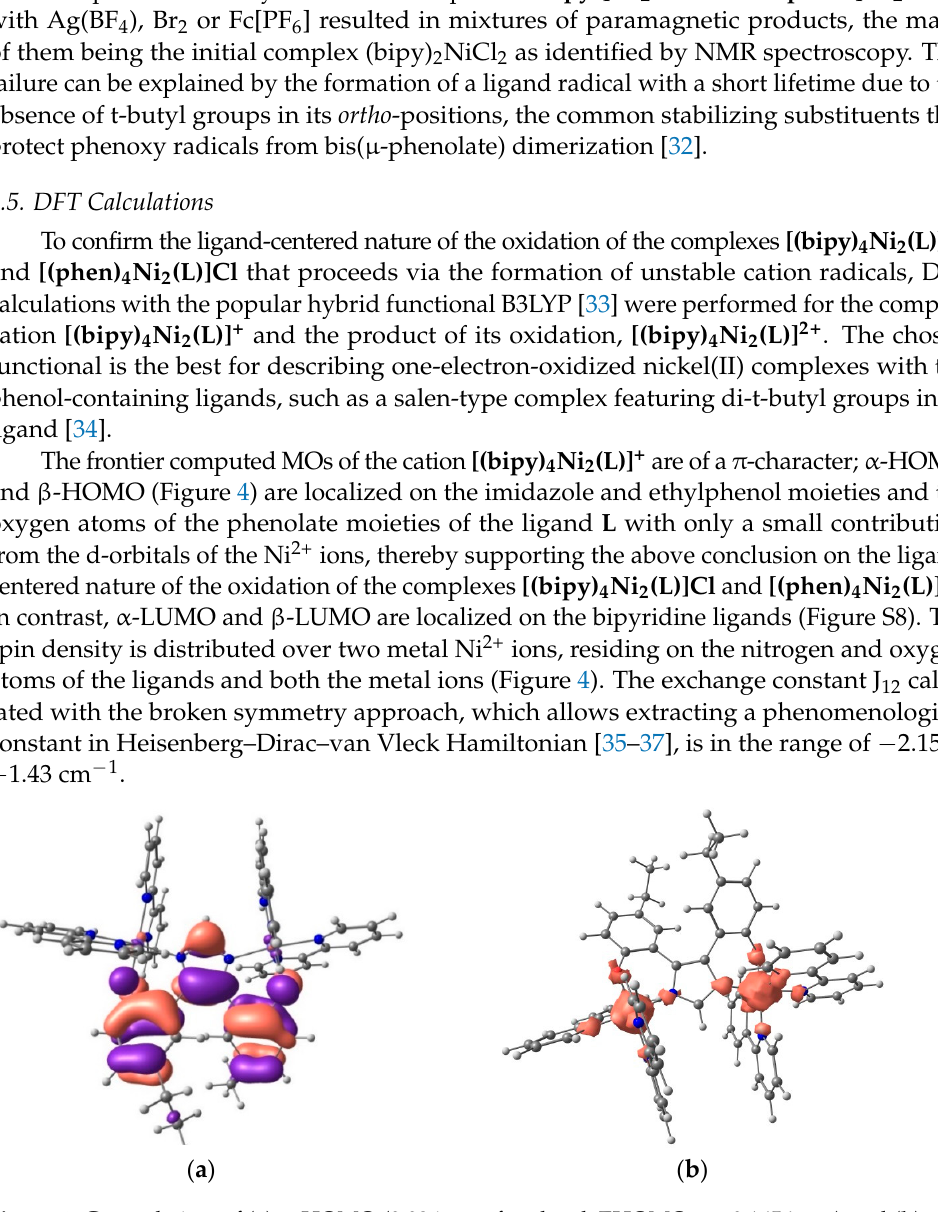
Figure 4. General view of ( a ) α‐ HOMO (0.03 isosurface level; EHOMO = − 0.1656 a.u.) and ( b ) spin density (0.0065 isosurface level) in the cation [(bipy) 4 Ni 2 (L)] + . The calculated energy level diagrams for [(bipy) 4 Ni 2 (L)] + and [(bipy) 4 Ni 2 (L)] 2+ (Fig ‐ ure 5) show that β‐ MOs in the nonoxidized species lie lower than α‐ MOs. The same pat ‐ tern is observed for the oxidized species. In this case, however, the energy difference be ‐ tween α‐ and β‐ MOs is larger, e.g., | Δ E| for α‐ 273 and β‐ 268 is 0.0096 a.u. The MOs of [(bipy) 4 Ni 2 (L)] 2+ are lower in energy than those in [(bipy) 4 Ni 2 (L)] + , with | Δ E HOMO | equal to 0.032 a.u. Figure 5. Calculated energy level diagram for α‐ and β‐ MOs in the cation [(bipy) 4 Ni 2 (L)] + and its oxidized form [(bipy) 4 Ni 2 (L)] 2+ . For the oxidized species [(bipy) 4 Ni 2 (L)] 2+ , the frontier α‐ orbitals are very similar to those in the complex cation [(bipy) 4 Ni 2 (L)] + (Figures 4, 6, S8 and S9); however, the spin density distribution is quite different (Figure 5). In [(bipy) 4 Ni 2 (L)] 2+ , it has an out ‐ of ‐ plane π‐ character and is located on the carbon atoms of the phenyl rings, the oxygen atoms of the phenolate moieties of the ligand L and the nitrogen atoms of the bipy ligands (Figure 6). Some of the spin density is also located on the two nickel ions. The same trend is ob ‐ served for [(phen) 4 Ni 2 (L)] 2+ (see Figures S10–S12). These results confirms that upon one ‐ electron oxidation, the electron leaves the ligand site rather than a Ni 2+ ion, thereby